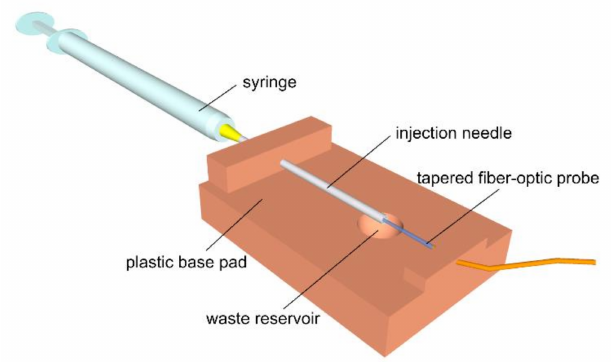
Figure 3. Diagram of the measuring cell.